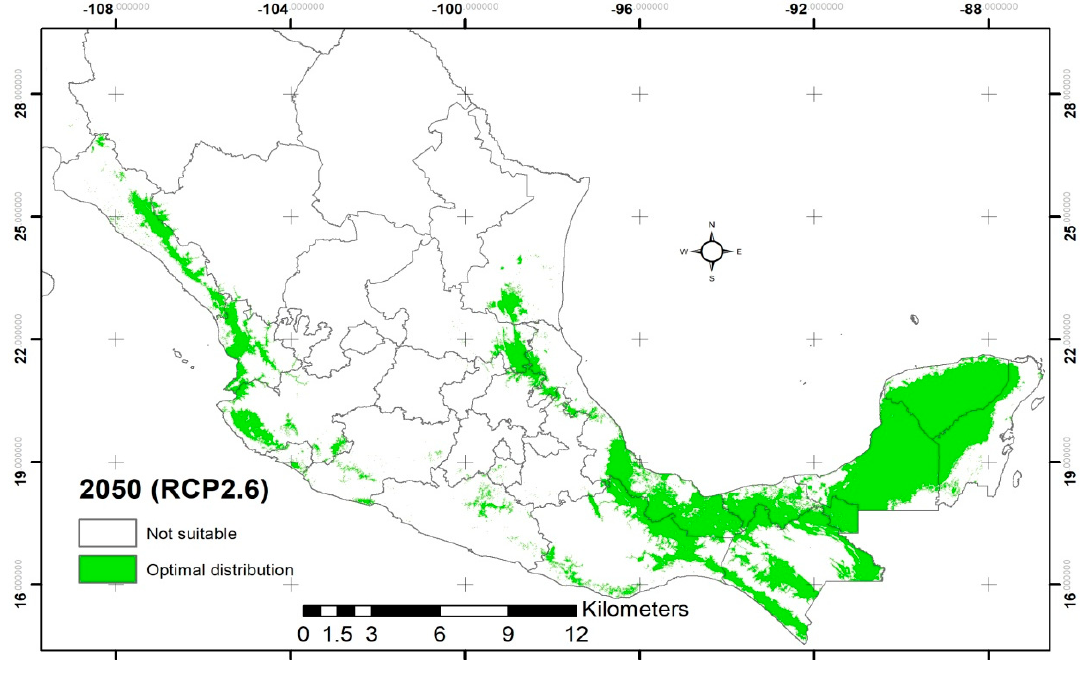
Figure 2. Potential distribution for the intermediate future (2050) of C. odorata in the NCAR model (CCSM4); for the conservative (RCP2.6) and drastic (RCP8.5) scenarios according to the optimum germination temperature range. For the drastic scenario (RCP8.5 Watts/m 2 ), it is predicted that the potential distribu- tion will be of 241,533.21 km 2 with optimal climate habitat (Figure 2 and Table 1). This represents a 5.57% expansion compared with the current distribution. However, it repre- sents a 1.03% contraction compared with the conservative scenario in the intermediate future. According to the jackknife, the variables that contributed most to the model were Bio14 (43.3%), Bio6 (28.7%), Bio12 (9.7%), and soils (4.3%). The states in which the distribution surface with optimal temperatures for germina- tion will increase compared with the current model are Hidalgo (134%), Sonora (98%),